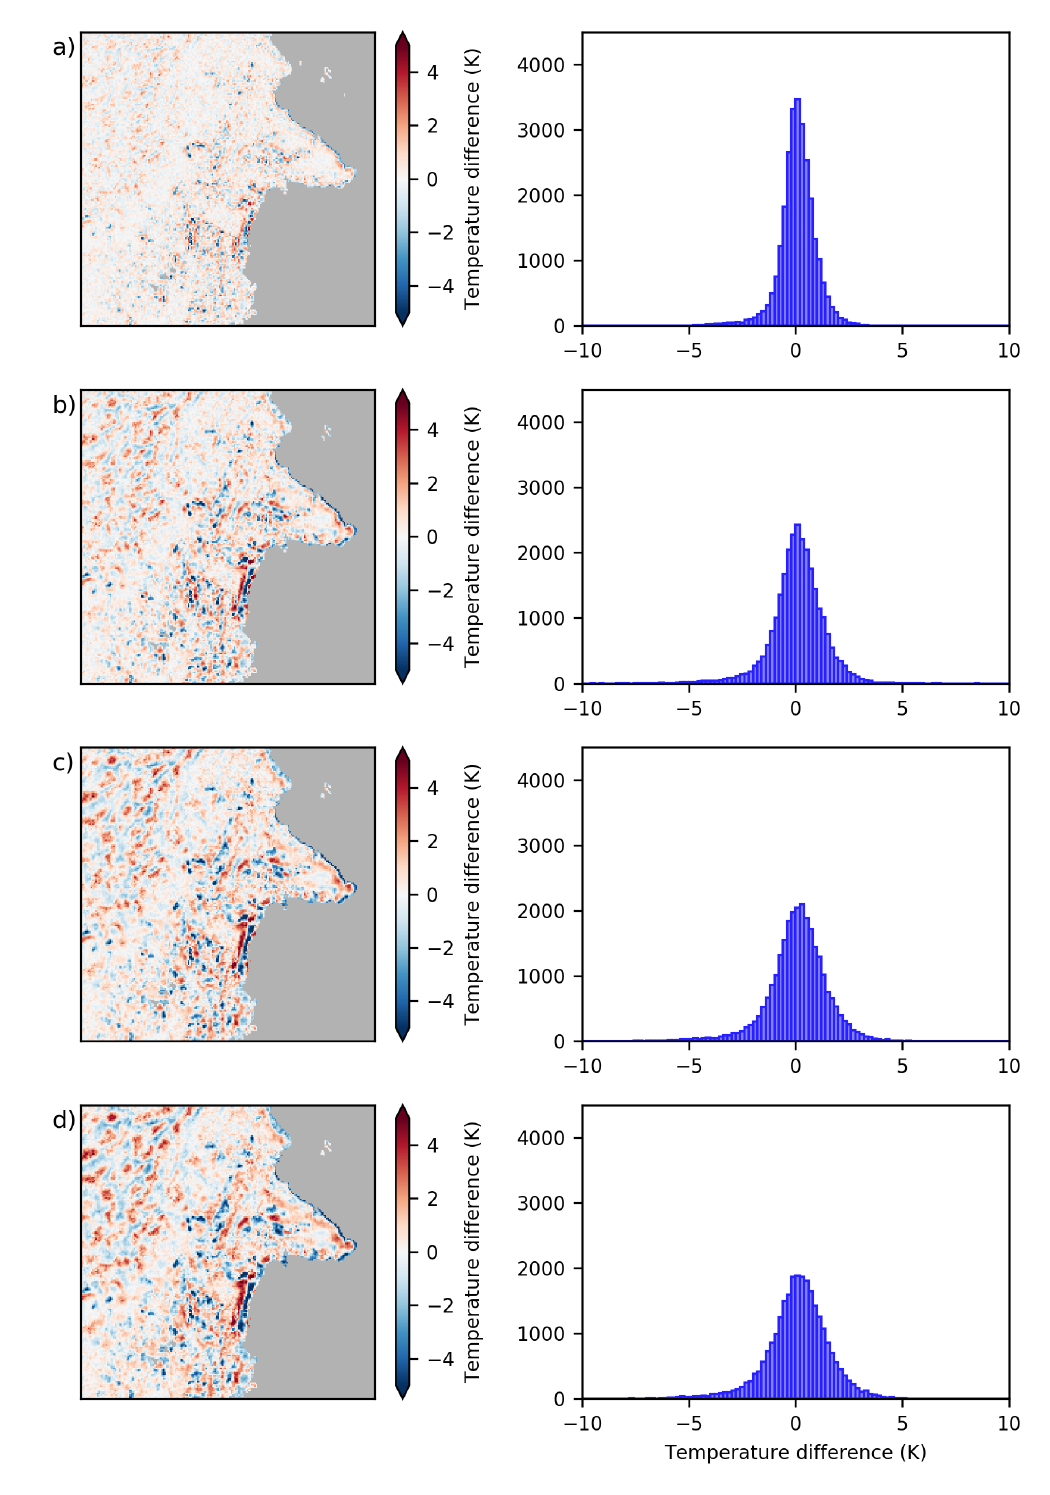
Figure A1. Changes in the spatial and statistical distribution of temperature estimates for the eastern Kalimantan (bor) study area by window size. Window levels shown are ( a ) 5 × 5 window; ( b ) 7 × 7 window; ( c ) 9 × 9 window; and ( d ) 11 × 11